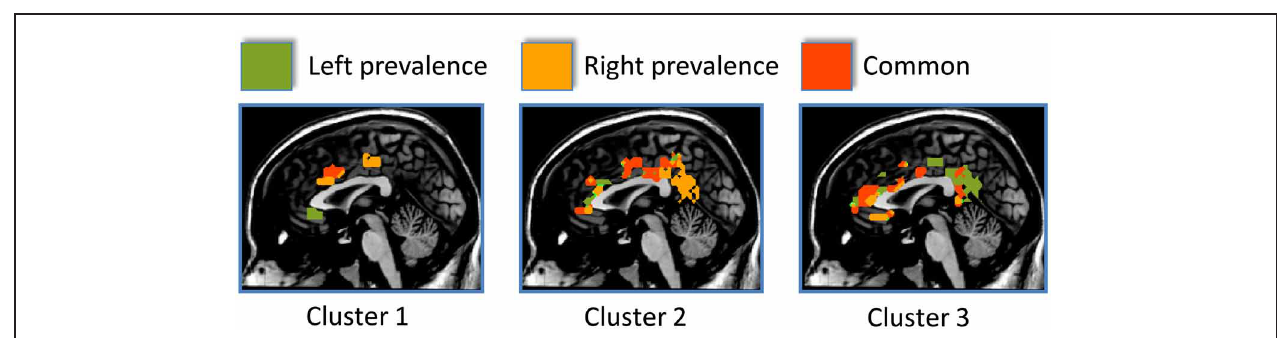
FIGURE 3 | The side differences for each cluster are shown here. Areas showing a left prevalence are coded in green, areas showing a right prevalence are coded in orange, areas equally lateralized are coded in red.